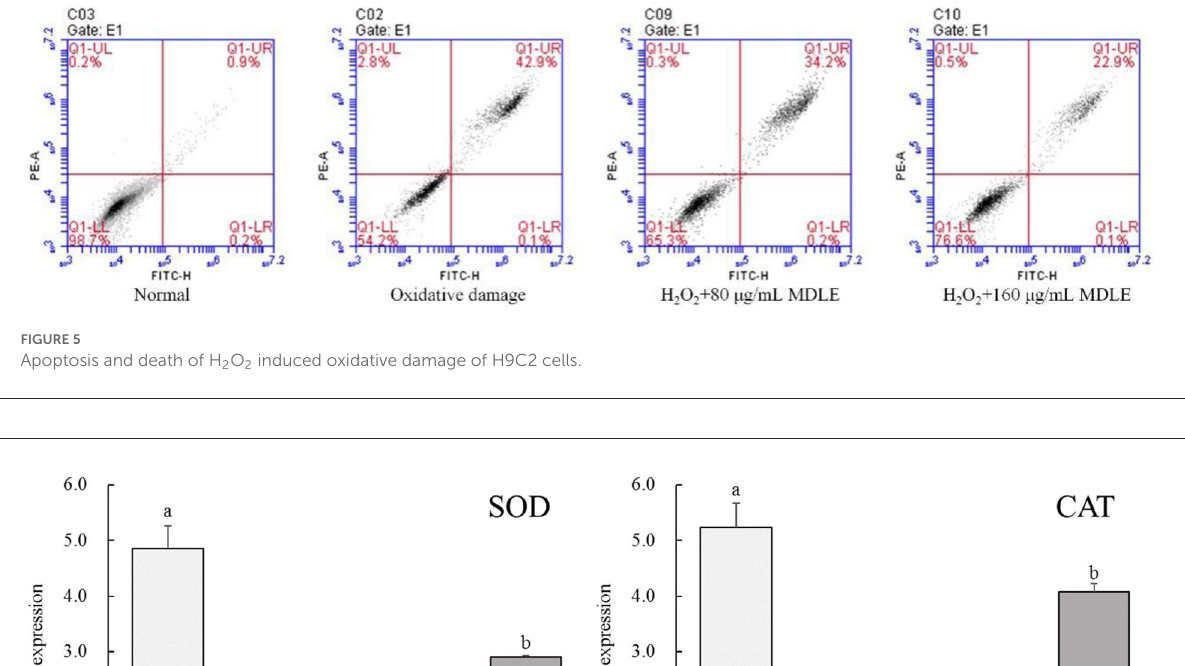
is an important aspect of studying functional factors